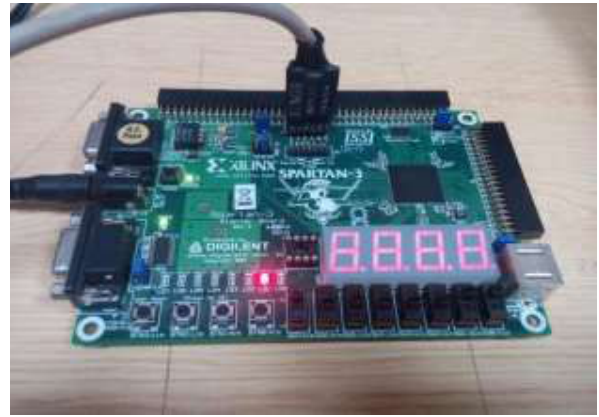
Figure 7(c). Packet leaving router